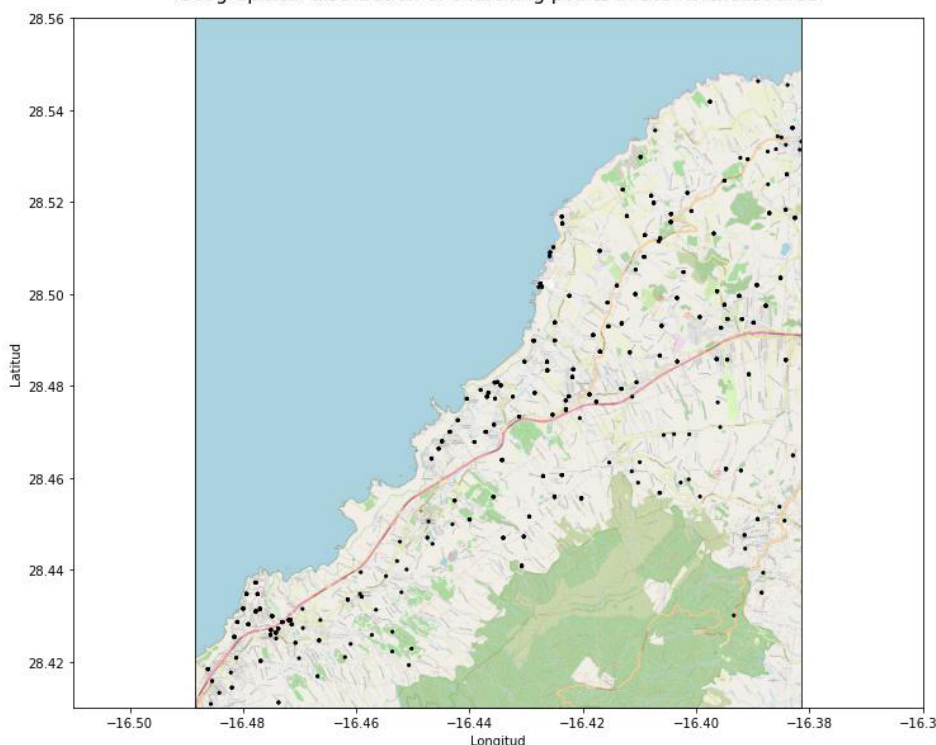
Figure 22. Distribution of charging points in Güímar Valley with each black dot representing a charging point.